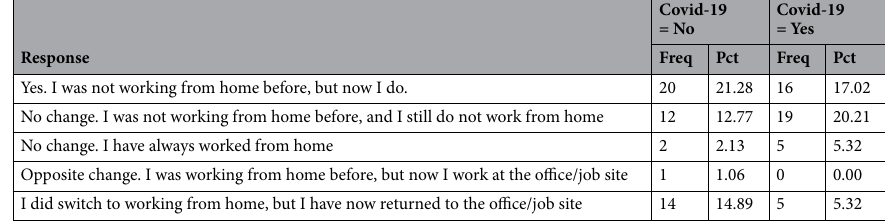
Table 2. Number of participants per work arrangement. Participants responded to the item: “Did you switch to working from home because of Covid-19?”.